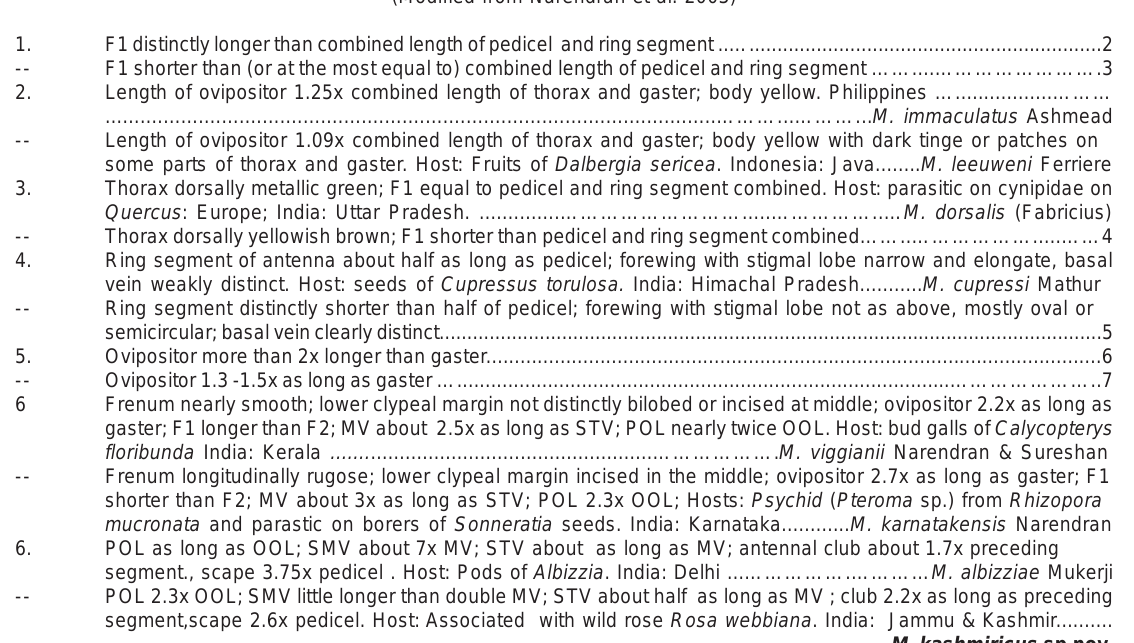
Male: Length 2.9-3.2mm. Colour mainly brownish black, including antenna, and thorax completely, gaster yellowish brown. 8 specimens out of 22 with dorsal part of thorax partly and gaster mainly yellowish. General morphology and structure similar to M. kashmiricus sp. nov. except for the following. Head with coarse longitudinal rugae on face completely, vertex with transverse striae in the form of rugae. Thorax with transverse striae coarser in the form of rugae on pronotal collar and mesoscutum completely. Scutellum